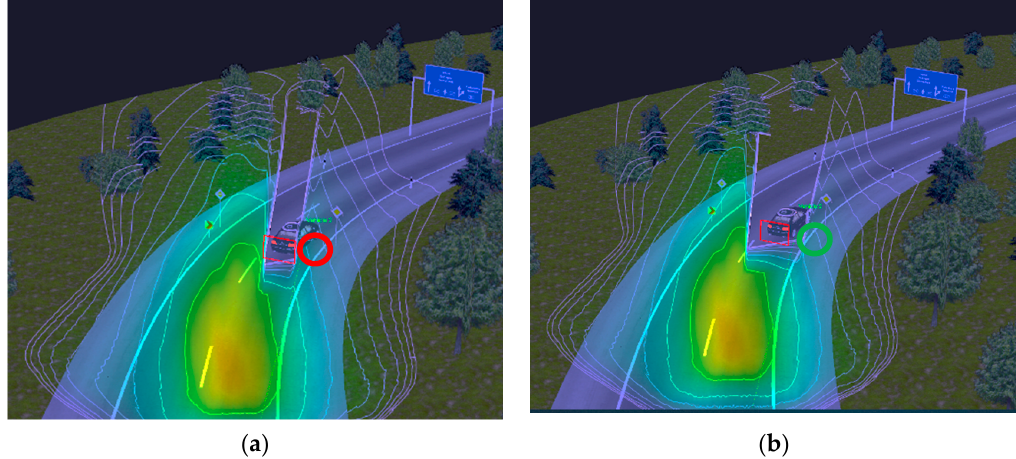
Figure 4. Effect on glare when altering non-glare zone width, showing that widening the non-glare zone could effectively eliminate glare: ( a ) 100% non-glare zone width (glare); ( b ) 150% non-glare zone width (no glare).